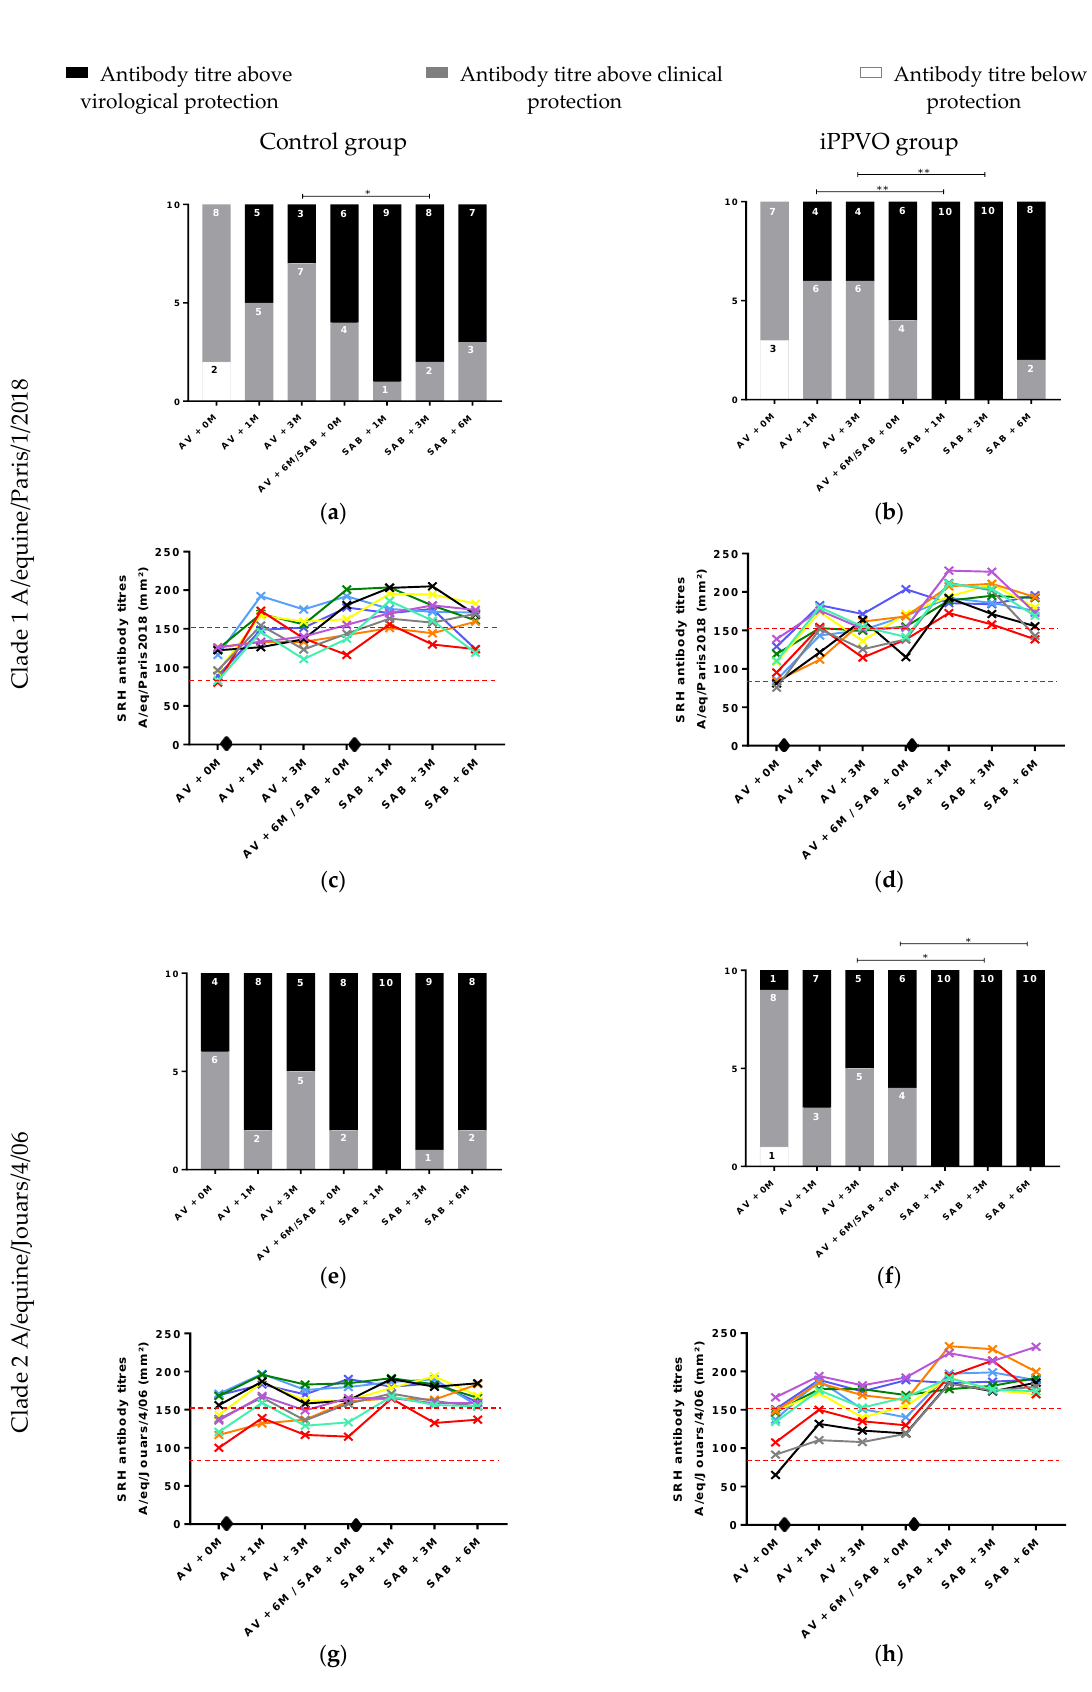
Figure 3. Evolution of H3N8 antibody response to simple radial haemolysis (SRH) measured before and after annual vaccination (AV) and semi-annual vaccination (SAB) with or without iPPVO.